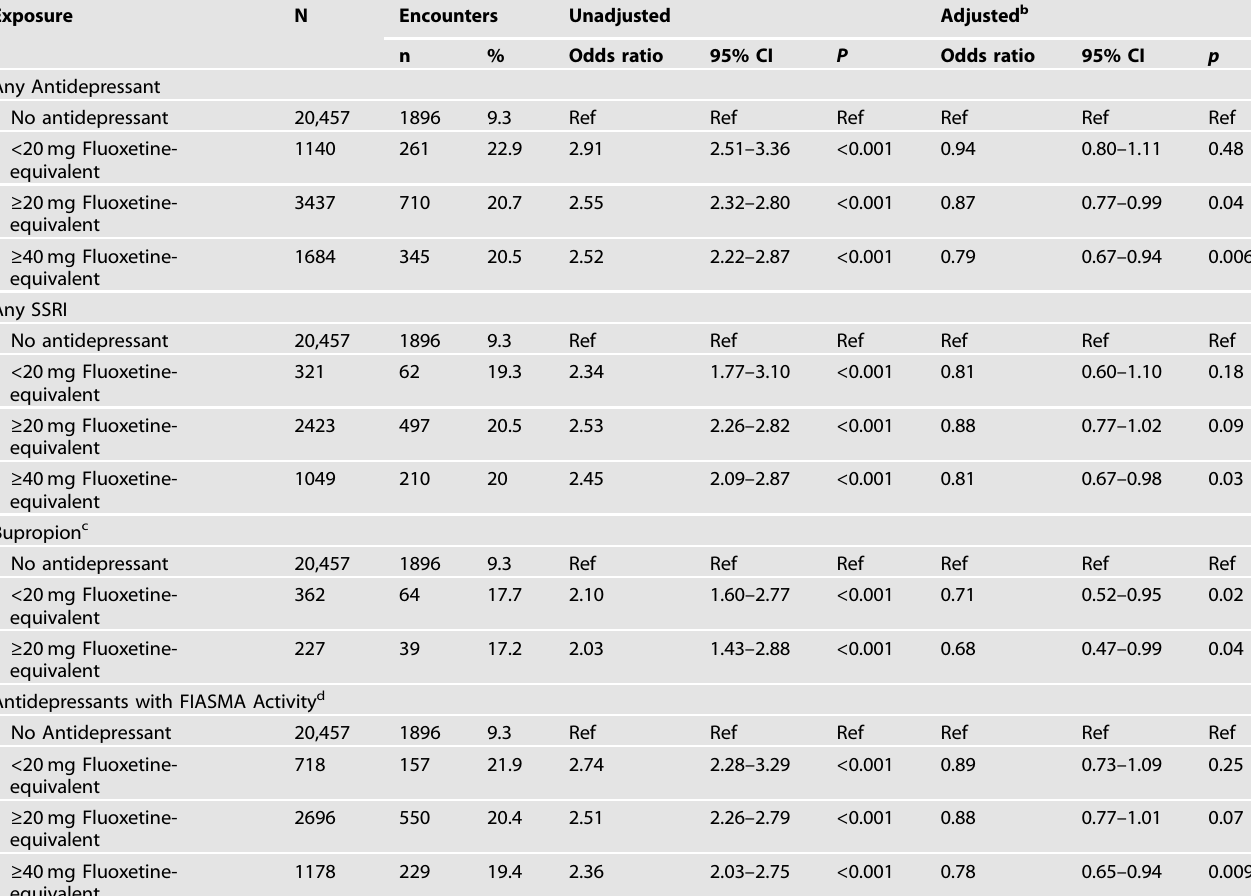
Table 4. Associations between selected antidepressant exposures and ED or hospital encounter within 30 days, strati fi ed by fl uoxetine-equivalent dose a